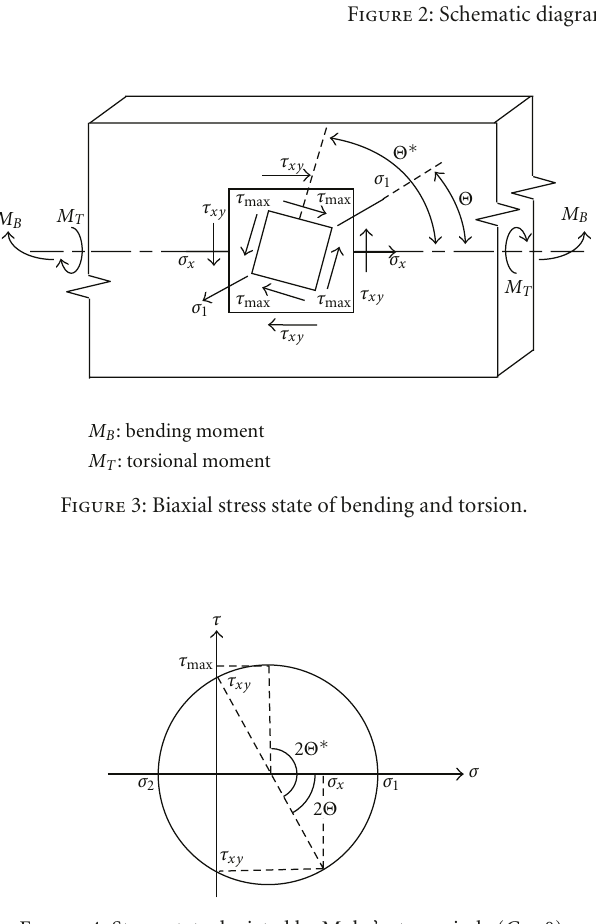
Figure 4: Stress state depicted by Mohr’s stress circle ( C < 0).